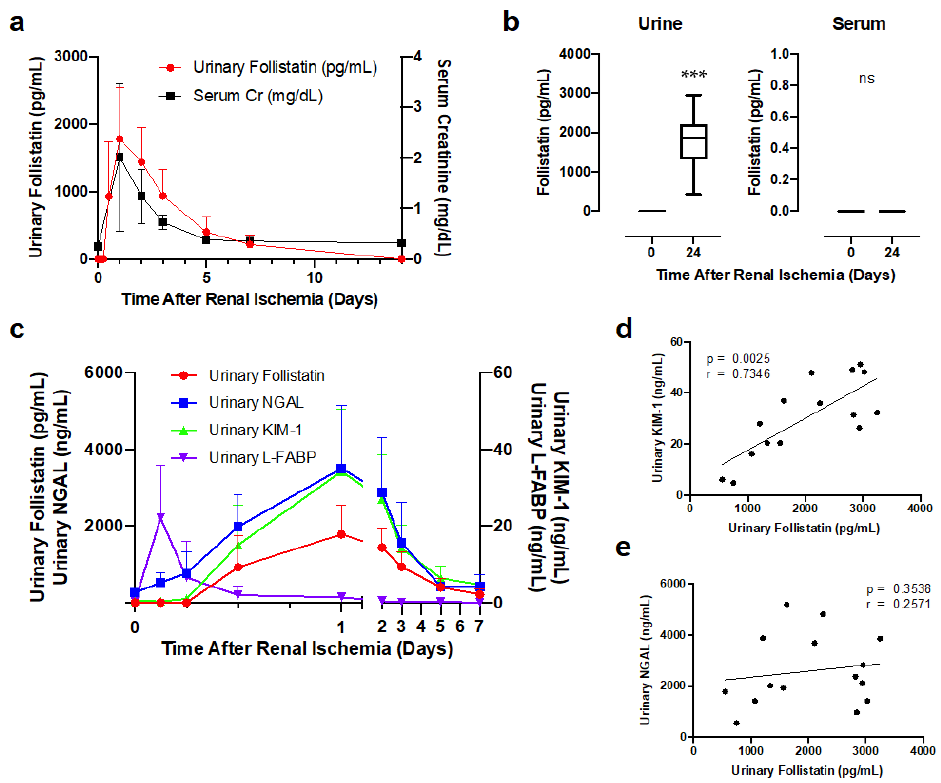
Figure 4. Urinary follistatin levels significantly increased after renal ischemia. ( a ) Time course changes in urinary follistatin and serum creatinine levels after reperfusion ( n = 8). ( b ) Urinary and serum follistatin levels in normal and renal ischemia (45 min) rats were measured by ELISA. Values are means ± S.E. ( n = 8). *** p < 0.001; N.S., not significant. ( c ) Time course changes in urinary follistatin, urinary NGAL, KIM-1, and L-FABP after reperfusion. ( d , e ) Correlations between urinary follistatin and urinary NGAL ( d ) or urinary KIM-1 ( e ) at 24 h after reperfusion. Renal ischemia (45 min) was performed, and urine was collected 24 h after